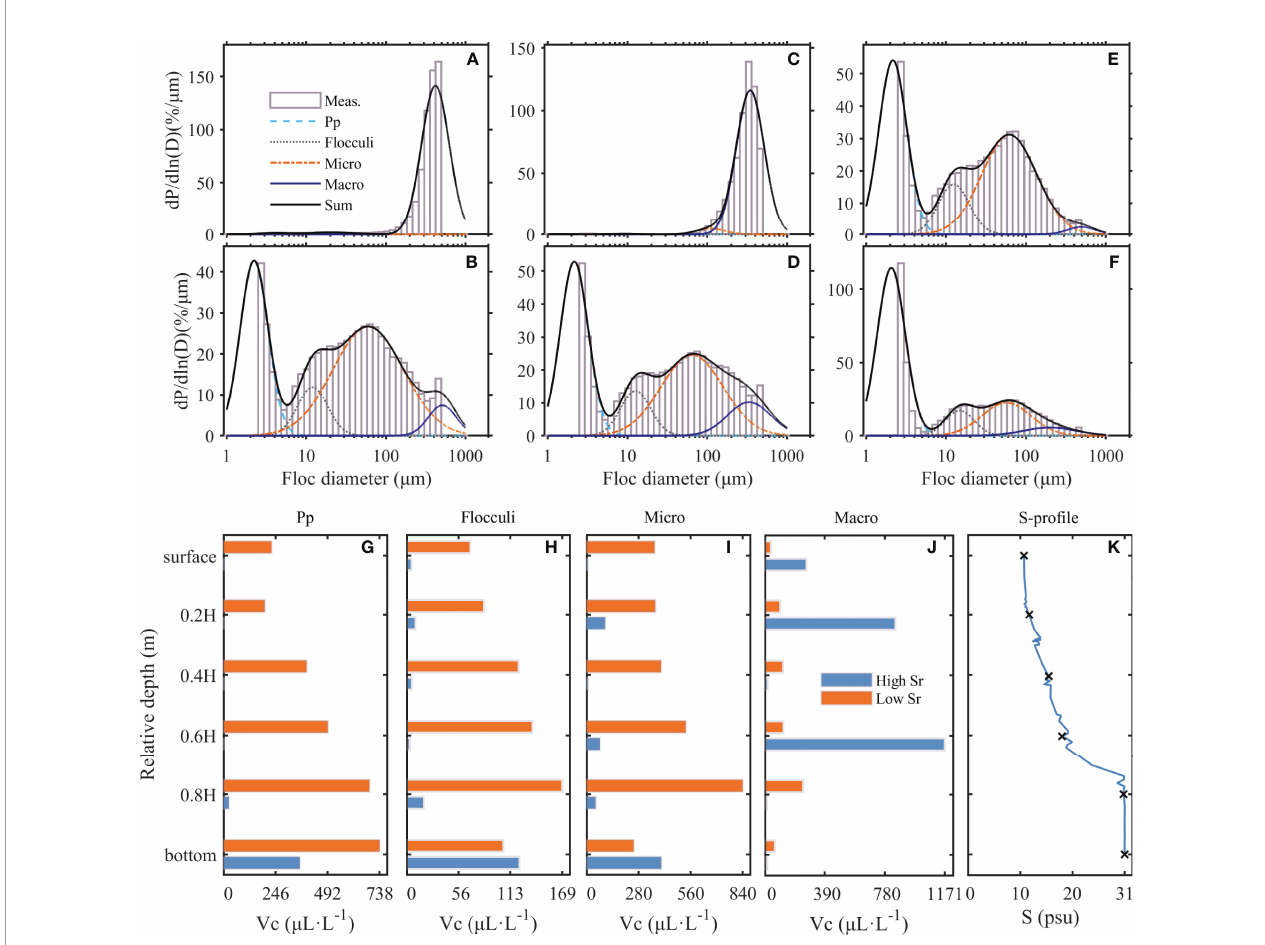
FIGURE 12 | (A, C, E) FSDs at the surface, middle, and bottom layers with strong salinity strati fi cation (High Sr , shown in Figures 4H, I , the blue squares); (B, D, F) FSDs at the surface, middle, and bottom layers with strong vertical mixing (Low Sr , shown in Figures 4B, C , the orange squares). Meas. presents a FSD measured by the LISST instrument, and Sum indicates the superposition of the decomposed FSDs. (G – J) Different fl oc fraction volume concentration variations in the relative depth from the surface layer to the bottom layer; and H in High and Low Sr conditions were 4.10 and 3.33 m measured by the ADCP, respectively. (K) Salinity pro fi le in the strong salinity strati fi